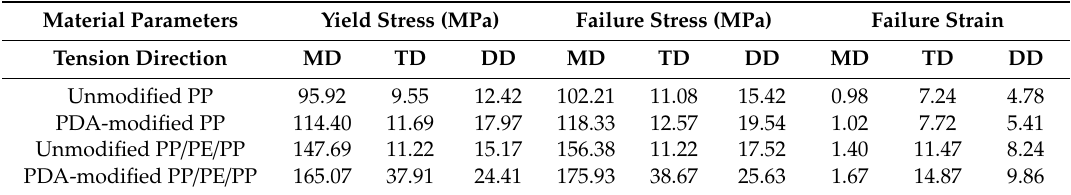
Figure 8. Electrochemical performances of cells with unmodified and PDA-modified separators: ( a,d ) discharging rate capacities; ( b,e,c,f ) galvanostatic charge-discharge curves at di ff erent current rates; ( g–i ) electrochemical impedance spectroscopies. Table 2. Material parameters of unmodified and PDA-modified separators along transverse direction (TD), machine direction (MD), and diagonal direction (DD) under strain rates 0.002 s − 1 .